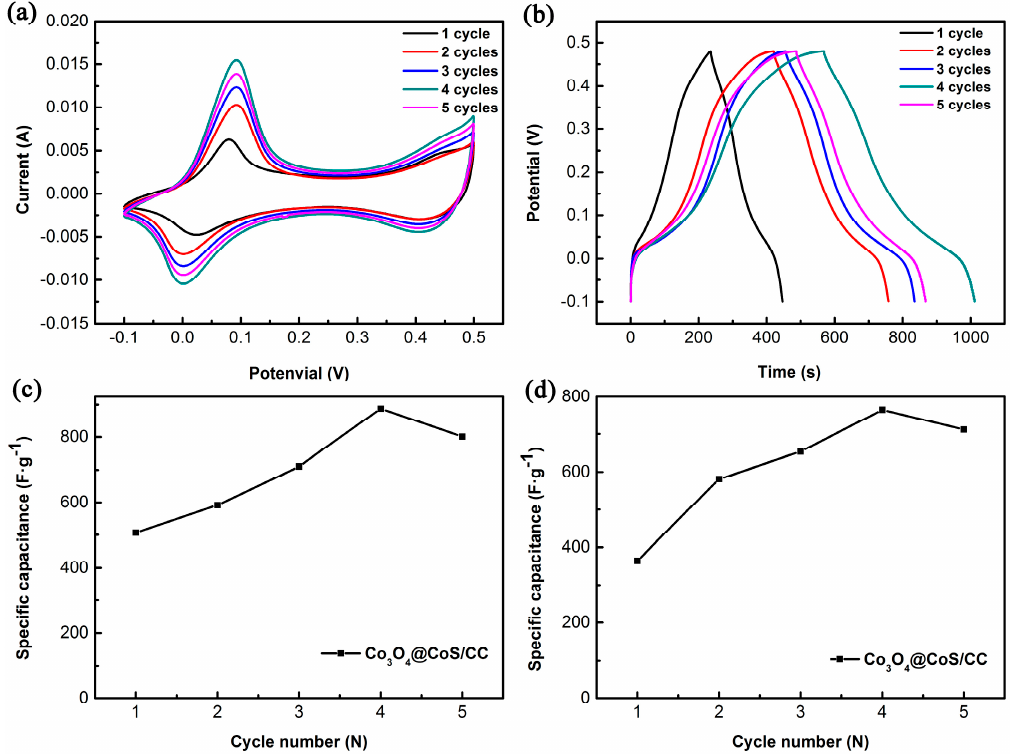
Figure 5. ( a ) CV curves of Co 3 O 4 @CoS/CC at different electrodeposition cycles of CoS; ( b